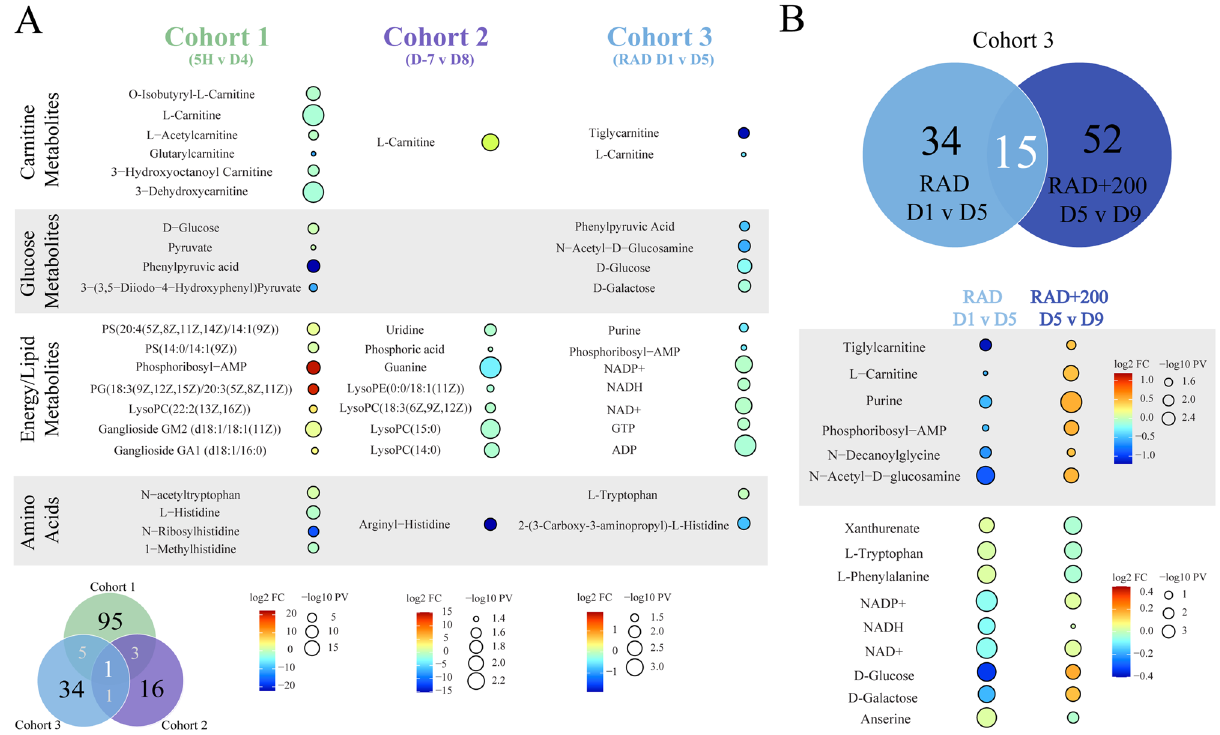
Figure 3. Overview of metabolite changes resulting from exposure to 60 Co γ-radiation. ( A ) Venn diagram summarizing dysregulated metabolites from the three cohorts and raindrop plot illustrations of radiation effects in cohorts 1 to 3. ( B ) Venn diagram summarizing the metabolic pathways from cohort 3 that were dysregulated with or without amifostine treatment (200 mg/kg) and raindrop plot illustrations of shared metabolites between RAD D1vD5 and RAD+200 D5vD9. Raindrop plot illustration show model changes by fold change (logFC) and p-value (− log10